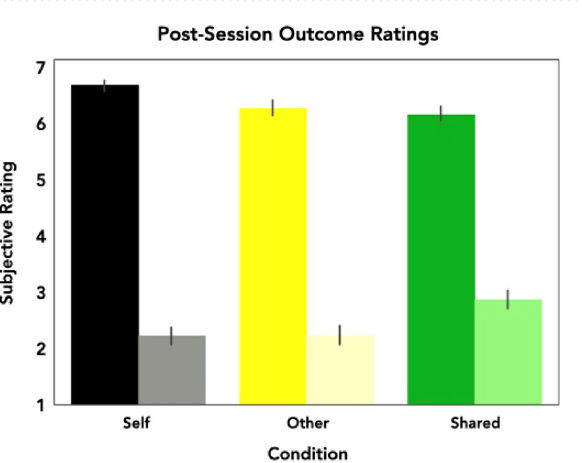
Figure 2. Post-session subjective ratings of experienced outcomes. A 2 × 3 × 2 mixed ANOVA revealed significant main effects of outcome and recipient on participants’ subjective ratings of wins and losses during the task (p’s < .02). Bars represented with saturated colors represent ratings for winning money in each condition; bars represented with pale colors represent ratings for losing money in each